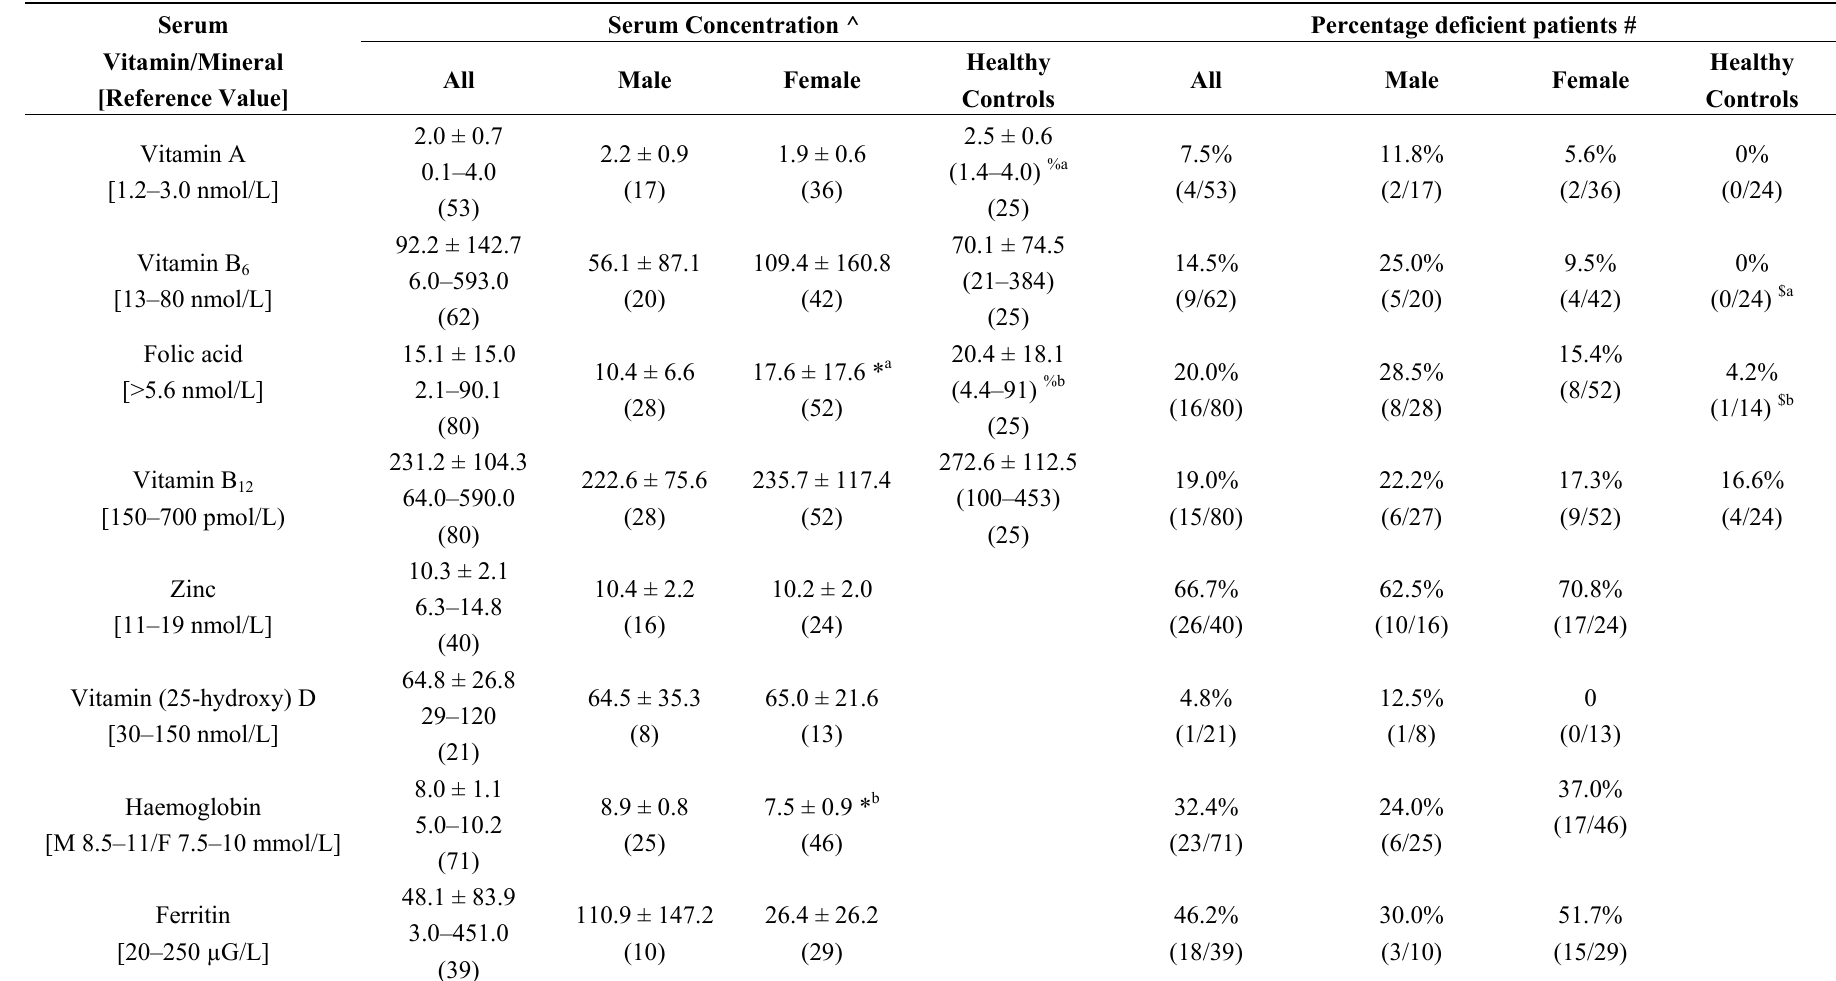
Table 3. Serum concentrations of nutritional biochemical parameters of untreated adult CD-patients (compared to healthy